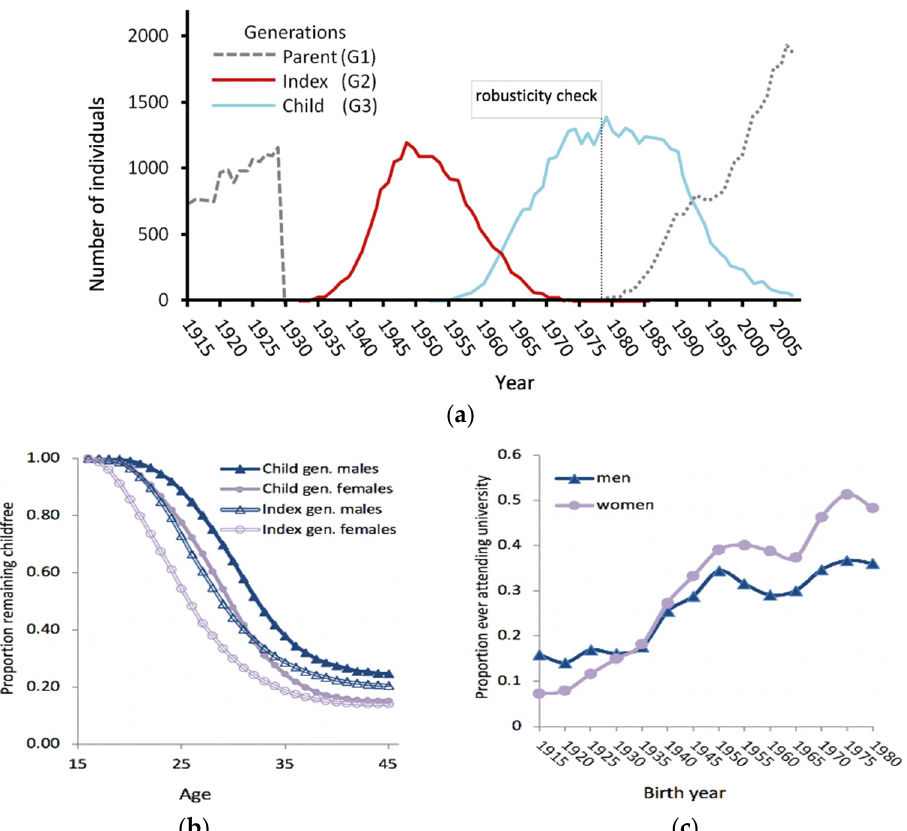
Figure 1. Historical changes in UBCoS cohorts. ( a ) Birth years by generation. The red solid line represents the index generation, the primary focus of this study. The child generation in solid light blue was used to test for historical changes in parental effects on first births. Their children are represented by the most recent dotted line. Robusticity checks of individuals older than 35 years of age when last seen would include individuals born before the vertical dotted line. ( b ) Survival curves for progression to first birth. The index generation is shown with open markers, and the child generation with filled in ones. Individuals who were censored for non-reproductive reasons were taken out of the analysis. ( c ) Proportion of adults ever attending university by end of 2009. Plotted by sex and earliest birth year in 5-year birth bands. Table 1. Descriptive statistics for all variables by cohort and gender. For clarity, standard deviations are omitted for cate- gorical variables and means refer to proportion of individuals within that category. NB: many in the child generation had not completed reproduction.